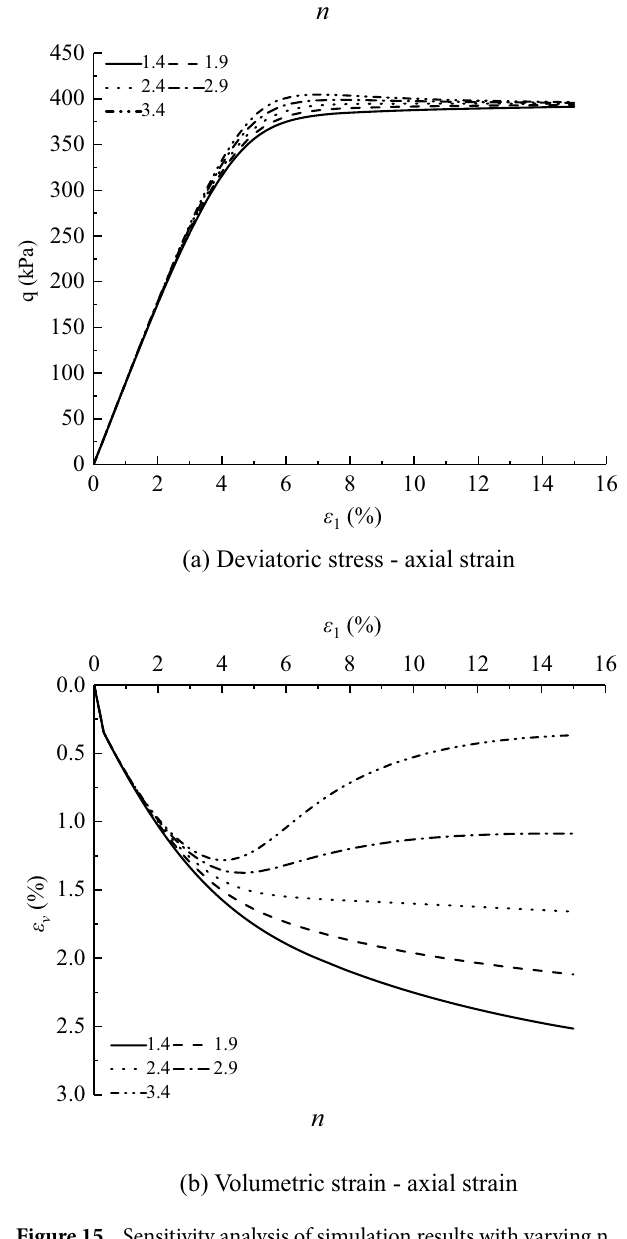
Figure 15. Sensitivity analysis of simulation results with varying